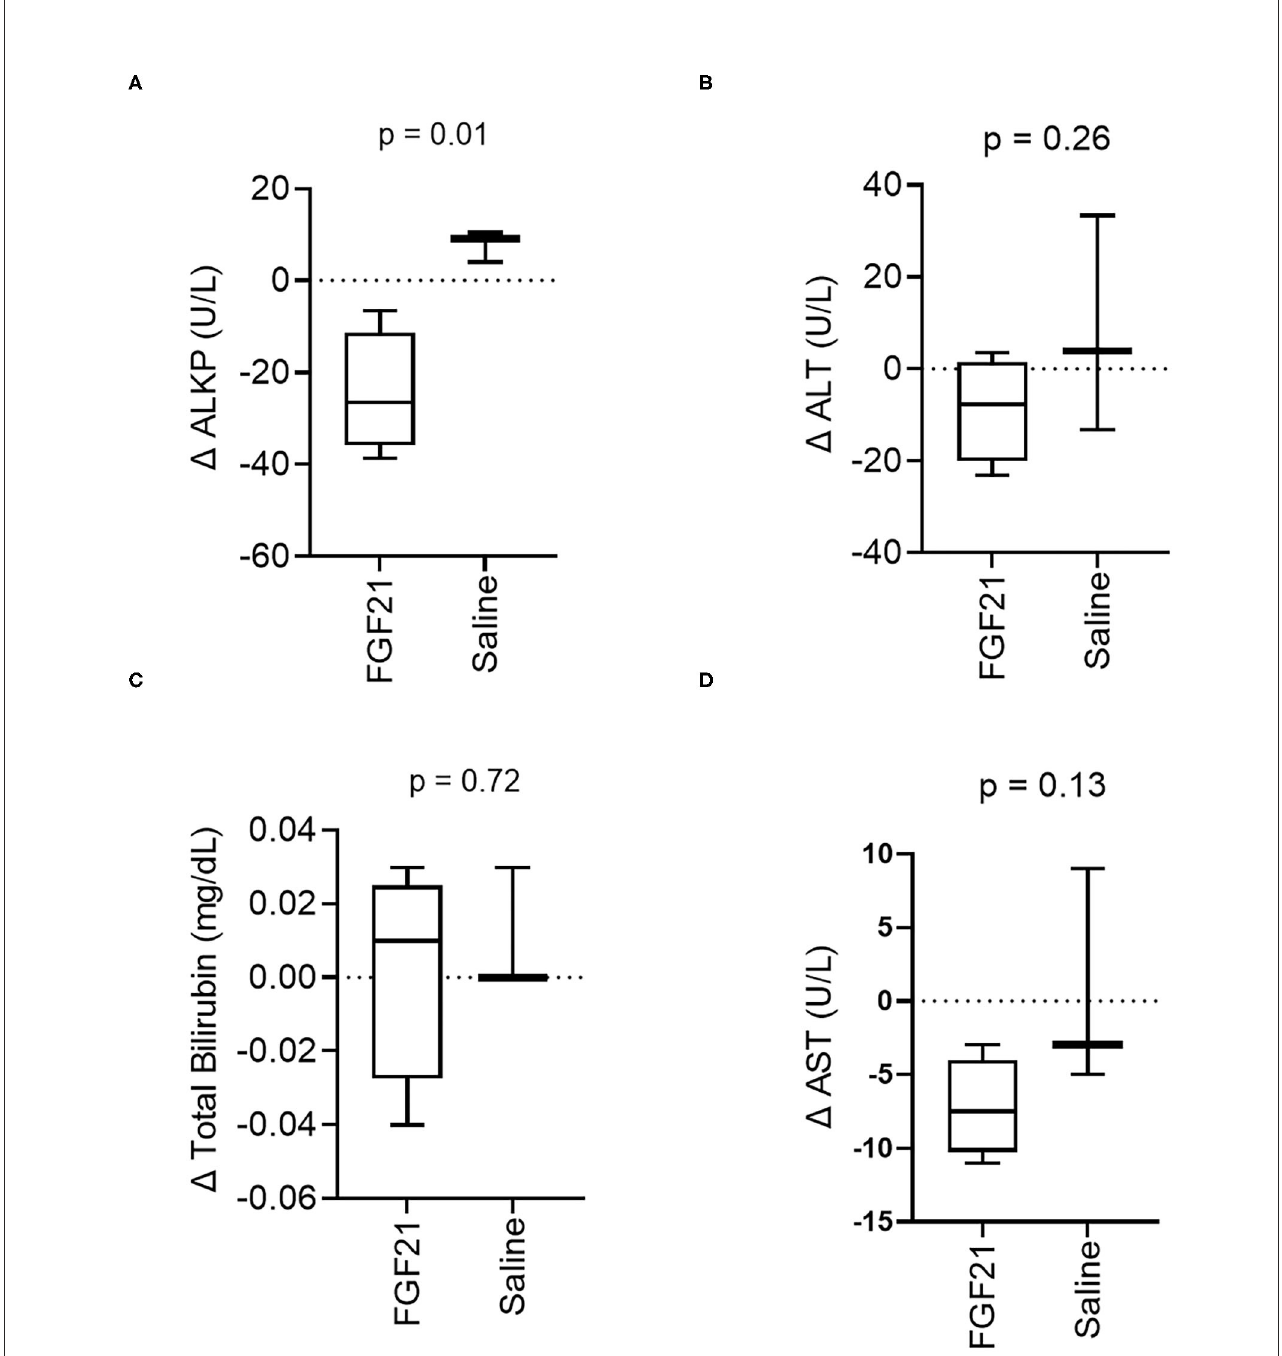
FIGURE4 Hepatic serum biomarker changes are consistent with decreased liver lipid content. (A) ALKP activity, an inducible liver enzyme and a sensitive indicator of hepatic lipidosis in cats, overall significantly decreases with FGF21 treatment (unpaired t -test). (B) ALT, (C) Total Bilirubin, and (D) AST are not altered by FGF21 treatment when compared to alterations by